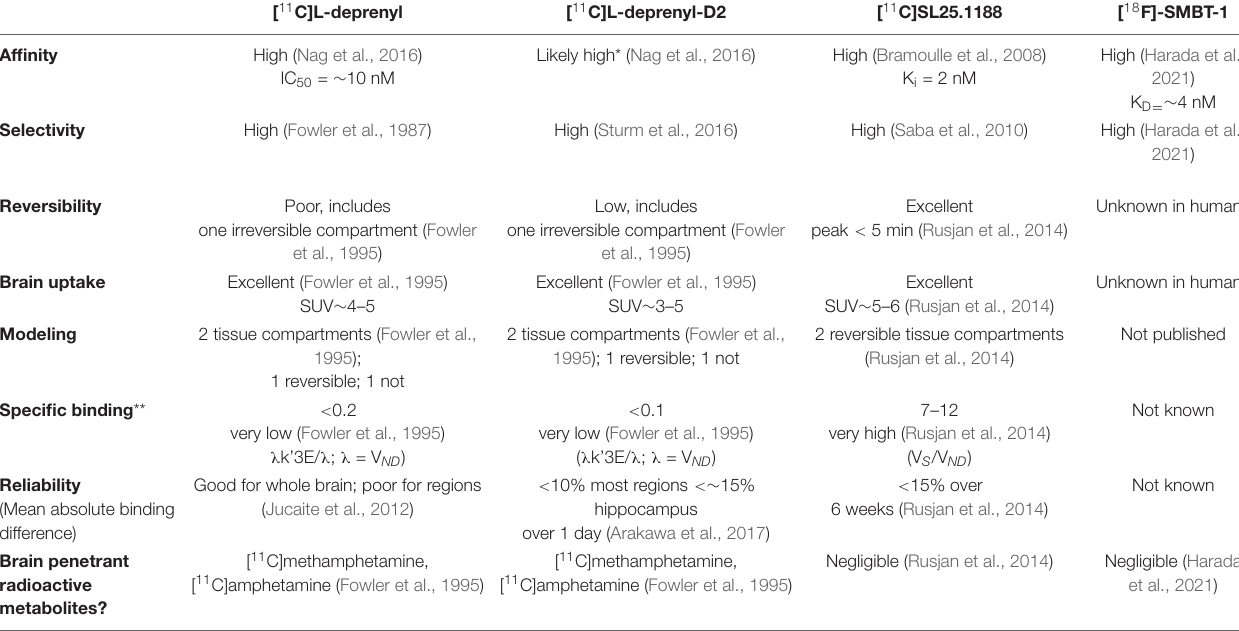
TABLE 2 | Comparison of PET imaging agents for central nervous system monoamine oxidase B applied in humans.